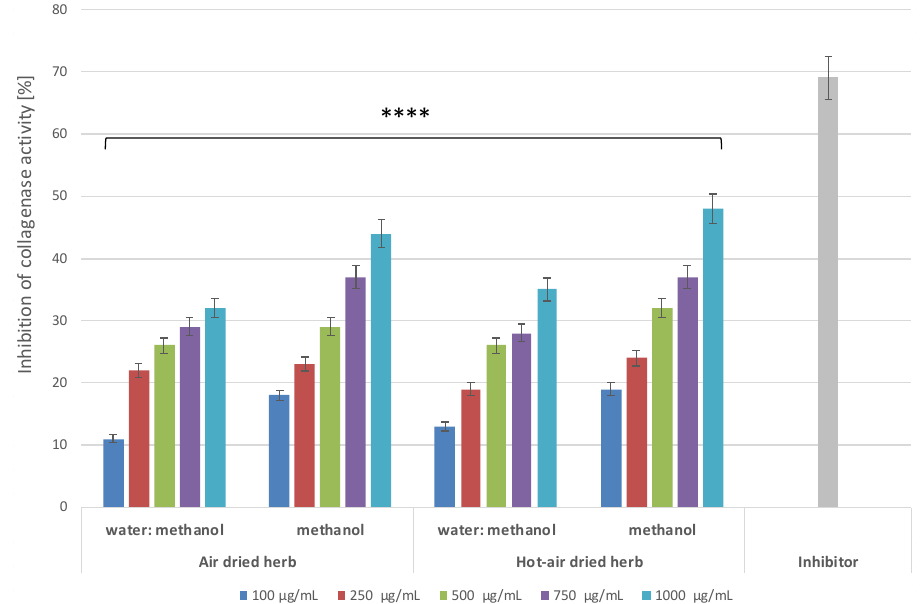
Figure 9. Collagenase inhibitory activity of B. officinalis extracts. Data are the means of three independent experiments, each consisting of two replicates per treatment group. **** p < 0.0001 versus the control.